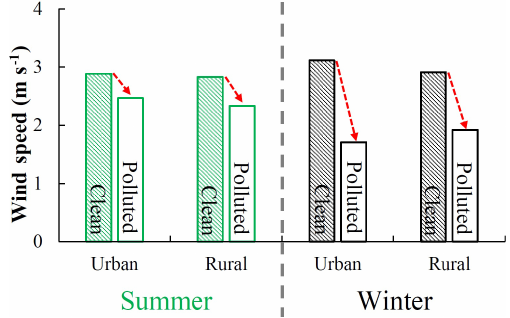
Figure 8. Comparison of average wind speeds (unit: ms − 1 ) of 35 cities between urban and rural areas under heavy air pollution (white bars) and clean conditions (hatched bars) in summer and